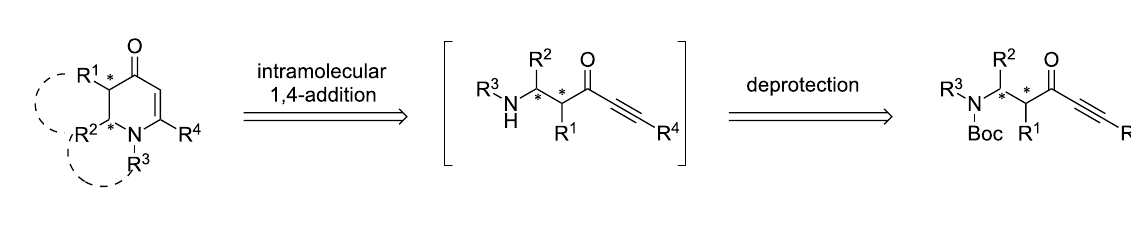
Scheme 1: Previously reported approach from β -aminoynones for the synthesis of pyridones.